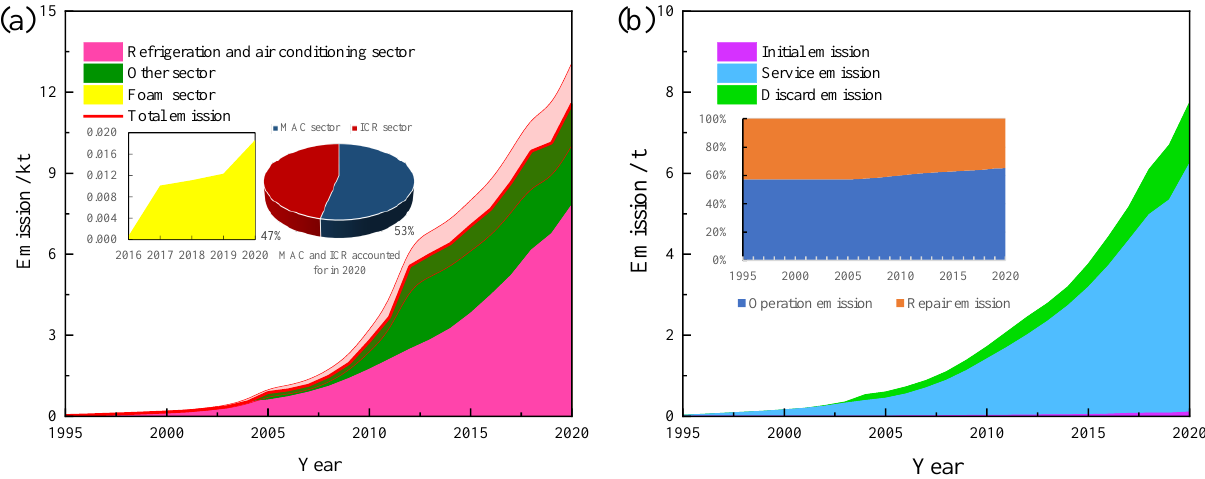
Figure 1. Historical emissions from 1995 to 2020 ( a ) by sector and ( b ) by life cycle stage. The red band in ( a ) represents the range of uncertainty for emissions.